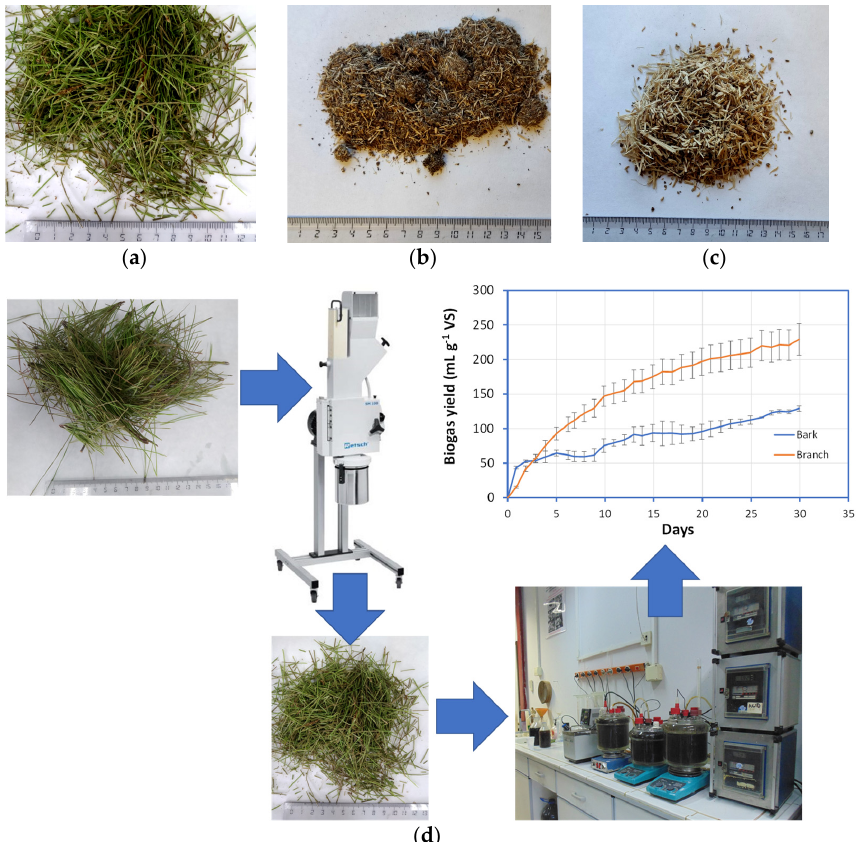
Figure 2. Photographic representation of ( a ) pine needles, ( b ) pine branches and ( c ) pine bark sam- ples after grinding pre-treatment, and ( d ) the laboratory setup used for the anaerobic digestion assays.